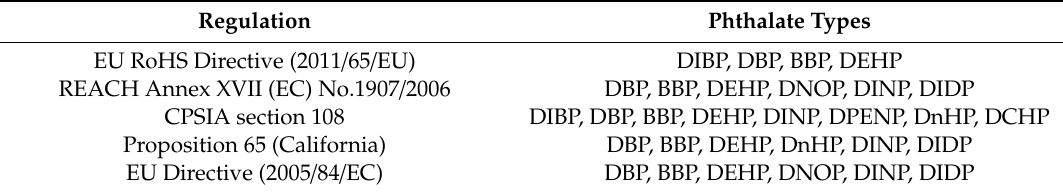
Table 1. Phthalate regulation in major chemical laws (legal thresholds: 1000 mg / kg).